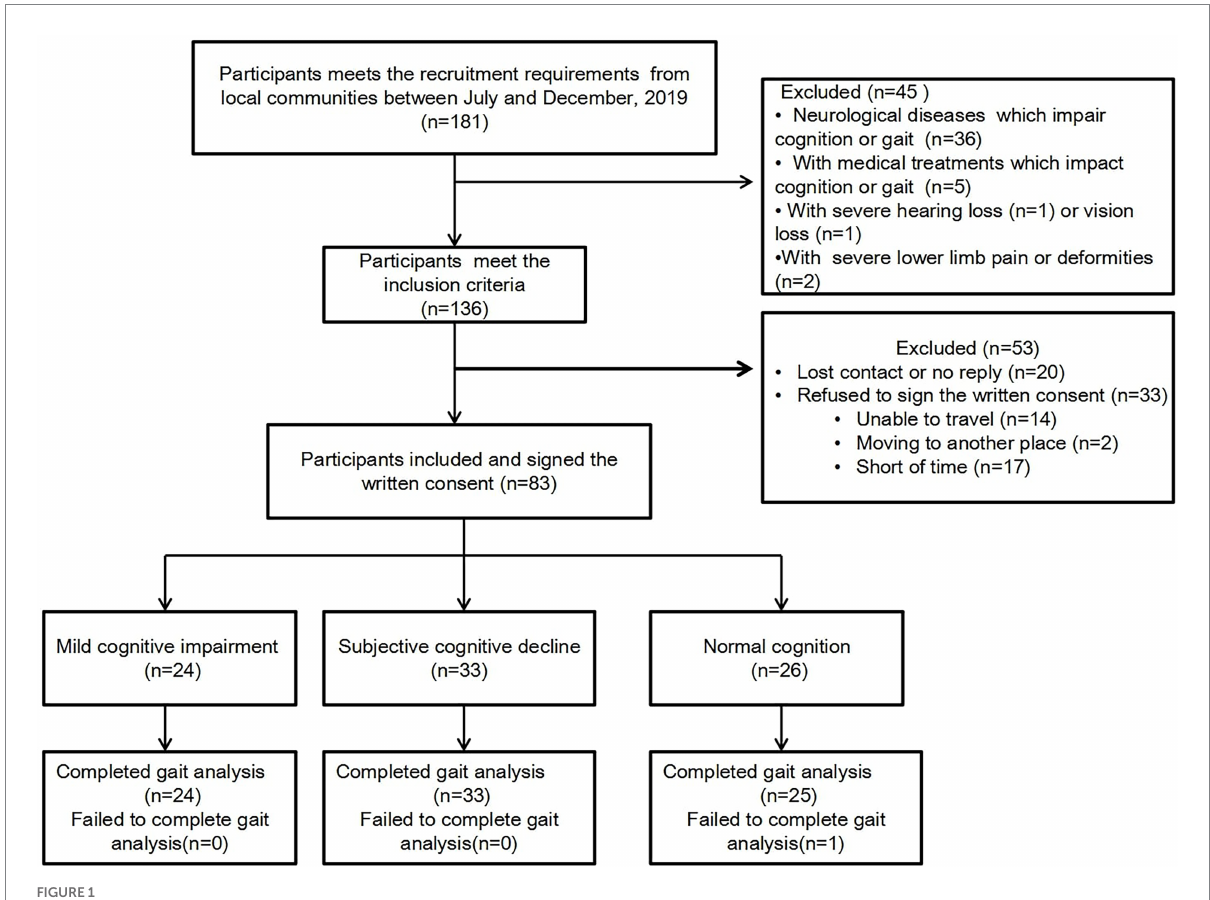
FIGURE 1 Study flow